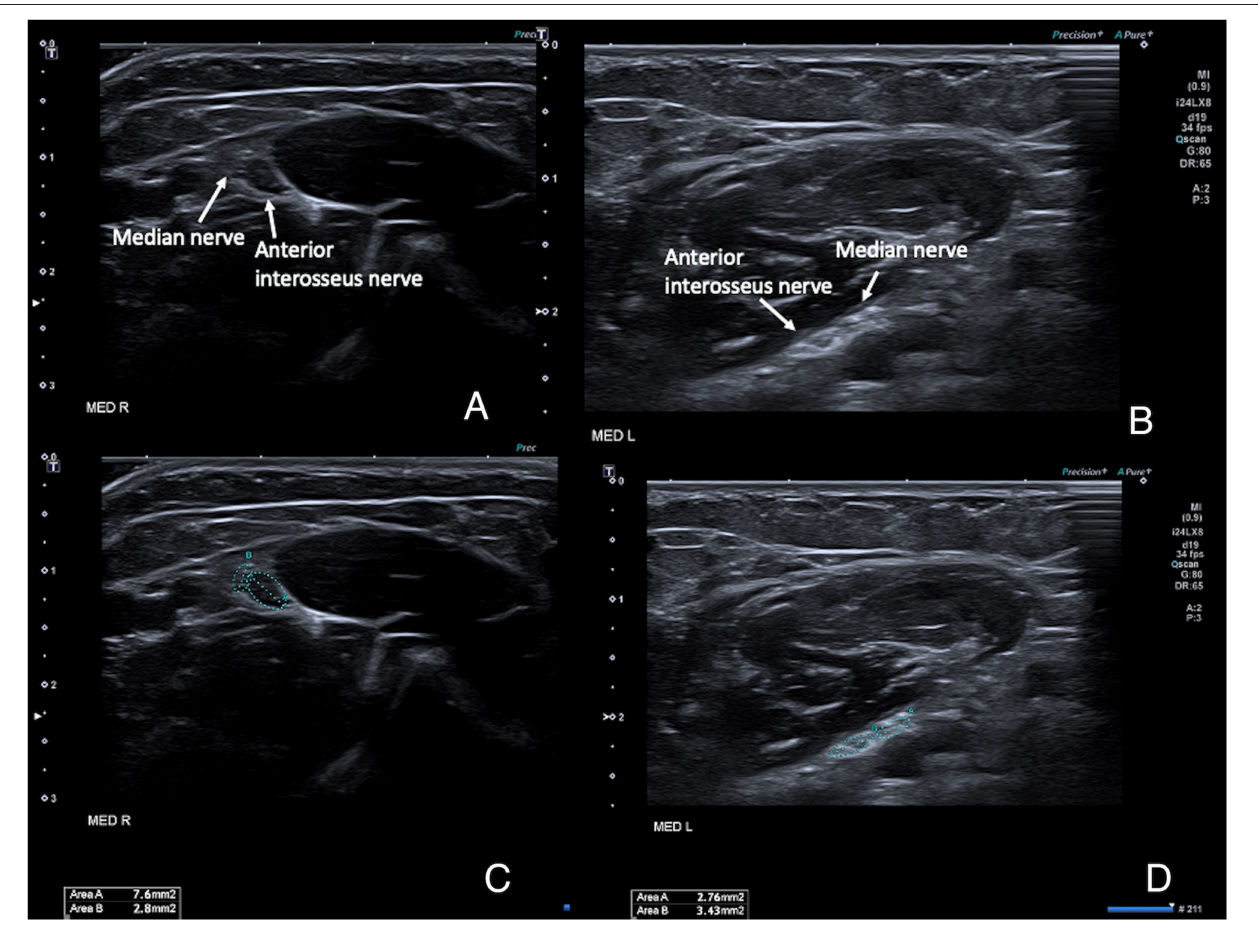
FIGURE 3 | High-resolution ultrasound images of the right (A,B) and left (C,D) median nerves at the level of the elbow, with the nerves running between the deep and superficial head of the pronator teres muscle. (A,C) show the anatomical configuration, with an unusually small median nerve proper and a comparatively larger anterior interosseus nerve, and even more pronounced on the right (where a thumb was present) which is the opposite of normal. (B,D) show the same images with the cross-sectional area measurements superimposed. Normal adult average reference cross-sectional areas (CSAs) in this region is around 7–9 mm 2 for the median nerve proper at the elbow level and 3–4 mm 2 for the anterior interosseus